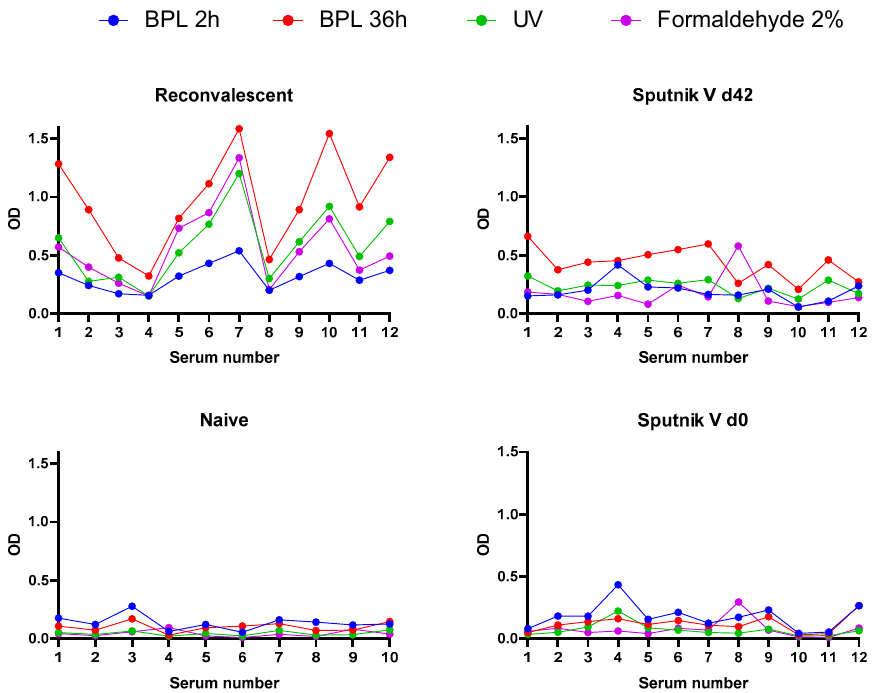
Figure 5. Immunoreactivity curves of inactivated virus preparations measured against sera of convalescent/naïve persons and paired sera of people vaccinated with Sputnik V. The absorbance data (OD 450) were plotted against the respective serum designated by a number; d0—the serum collected before the vaccination; d42—the serum collected on the 42nd day after vaccination; BPL 2 h— β -propiolactone (1:1000, 2 h); BPL 36 h— β -propiolactone (1:2000, 36 h). Table 3. Immunoreactivity of SARS-CoV-2 inactivated with different agents measured with ELISA. Area under Curve (AUC) ** Inactivated Sample/Sera *